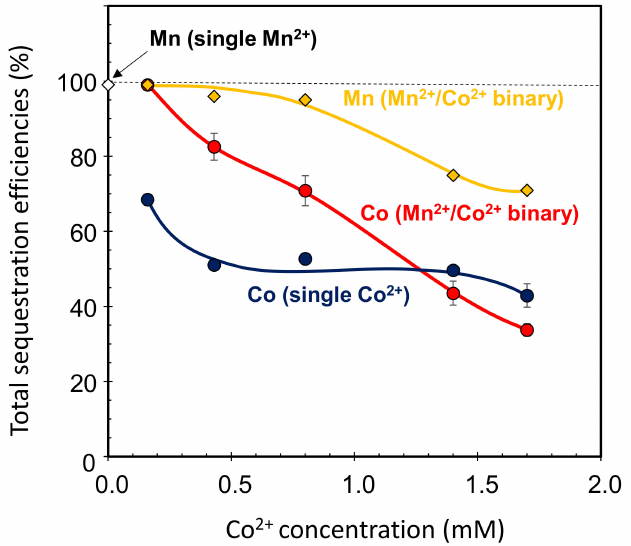
Figure 3. Total sequestration efficiencies for Co 2+ and Mn 2+ during repeated treatment experiments of newly formed biogenic manganese oxides (BMOs; 1 mM as Mn) in Co 2+ solutions (0.16–1.7 mM) with (Mn 2+ /Co 2+ binary) and without (single Co 2+ ) 0.8 mM exogenous Mn 2+ . Newly formed BMOs were also repeatedly treated in single Mn 2+ solutions at 0.8 mM (single Mn 2+ ) for